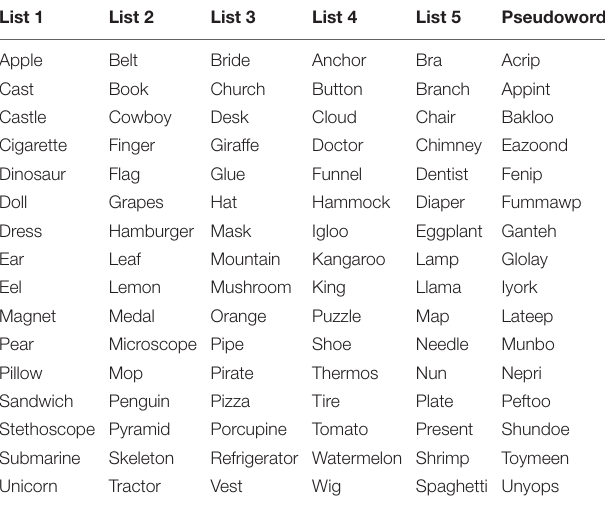
TABLE 1 | List of the spoken word stimuli used in the present